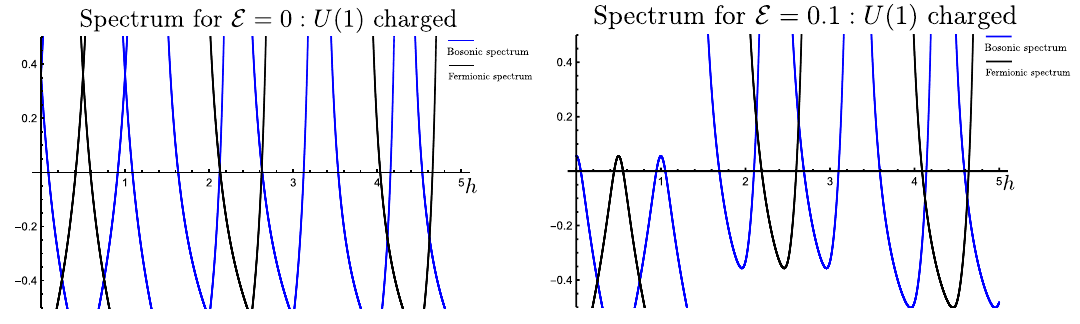
Figure 15 . Spectrum of the U (1) charged sector at distinct values of E